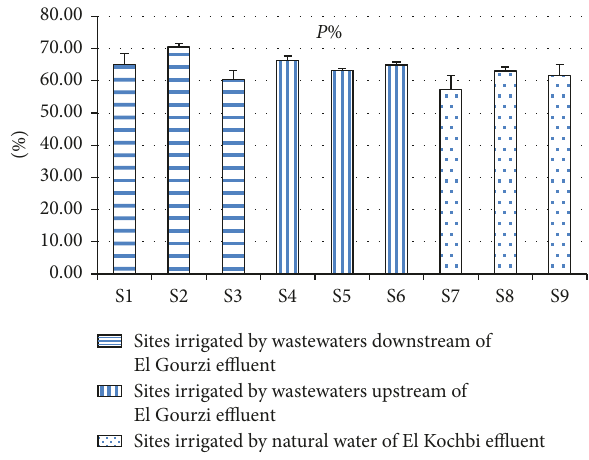
Figure 2: Total porosity average in study